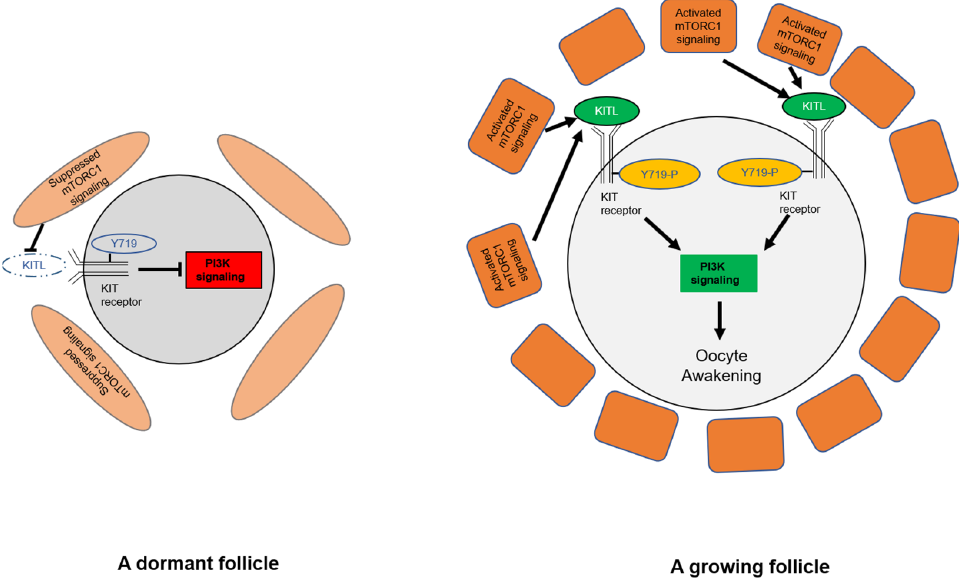
Figure 3. Pre-granulosa cells initiate the activation of primordial follicles through mTORC1–KITL signaling in pre-granulosa cells and KIT Y719–PI3K in oocytes. In dormant follicles ( left ), the mTORC1 signaling in pre-granulosa cells is suppressed, and only a low level of KITL is expressed by pre-granulosa cells, which is insufficient to activate KIT Y719 on oocytes. KIT Y719 is not phosphorylated and the intraoocyte PI3K signaling is suppressed in this situation. In growing follicles ( right ), activated mTORC1 signaling in the pre-granulosa cells leads to enhanced production of KITL that binds to c-kit and subsequently activates the intraoocyte PI3K signaling through phosphorylation of KIT Y719. Activated PI3K signaling in oocytes awakens the dormant oocytes.